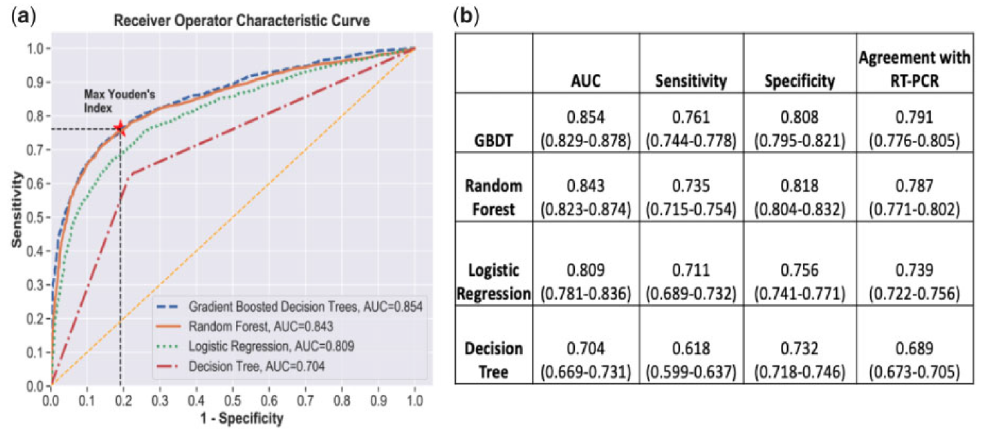
Figure 3. 5-Fold Cross-validation of the four models stated. ( a ) Comparison of ROC curves ( b ) com- parison of AUC, specificity, and sensitivity. Gradient Boosting DT is shown to be the best model